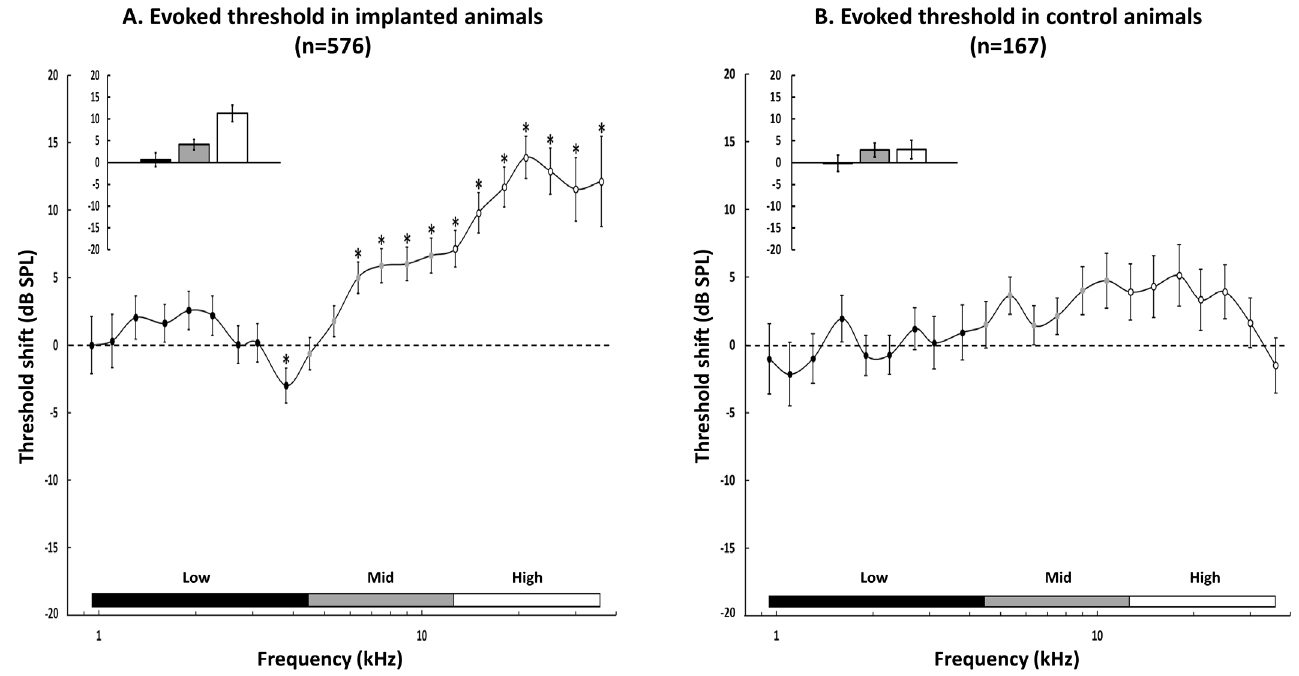
Figure 3. Quantification of the threshold changes in the cochlear-implanted animals ( A ) and in the control animals ( B ). ( A ) At each frequency used to test the Frequency Response Area (FRA), we automatically detected the threshold value before and after cochlear implant insertion and computed the threshold shift as the difference between the post and the pre value. Negative values indicate decreased thresholds and positive values indicate increased thresholds. The threshold changes (mean ± sem) are presented for the low frequencies (0.95–3.8 kHz, black dots), middle (4.5–10.7 kHz, grey dots), and high (12.7–36 kHz, white dots) frequencies. There were non-significant changes in the low frequencies. Starting in the middle frequencies (at 6.35 kHz), the thresholds were increased post-implantation and the maximum increase was around 14 dB. Asterisks represent significant changes post-insertion compared to pre-insertion (assessed by paired t-tests with a p -value < 0.05 after a Benjamini–Hochberg correction for multiple testing). The inset shows the mean threshold changes in the low, middle, and high frequencies. ( B ) Same representation as in A with the recordings obtained from the control animals. The threshold values were derived from a FRA collected at the 1st implantation of the cortical electrode matrix, then collected after a second implantation 30 min later. There was no change in the low frequencies and there were some slight increases in middle and high frequencies, but they were not significant. The inset shows the mean threshold changes in the low, middle, and high frequencies: these changes were significantly different from the CI-implanted animals in the high frequencies (see text for details). In A and B, * indicate significant differences between the Pre and Post values of threshold.